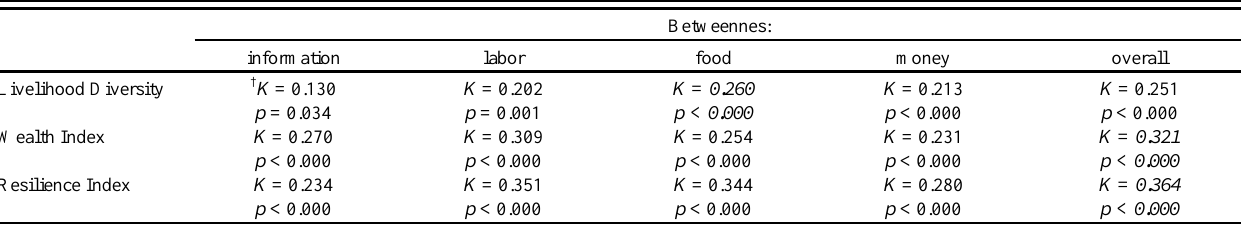
Table 5 . Nonparametric correlations between “betweenness” as an indicator of connectivity and the three different indicators of